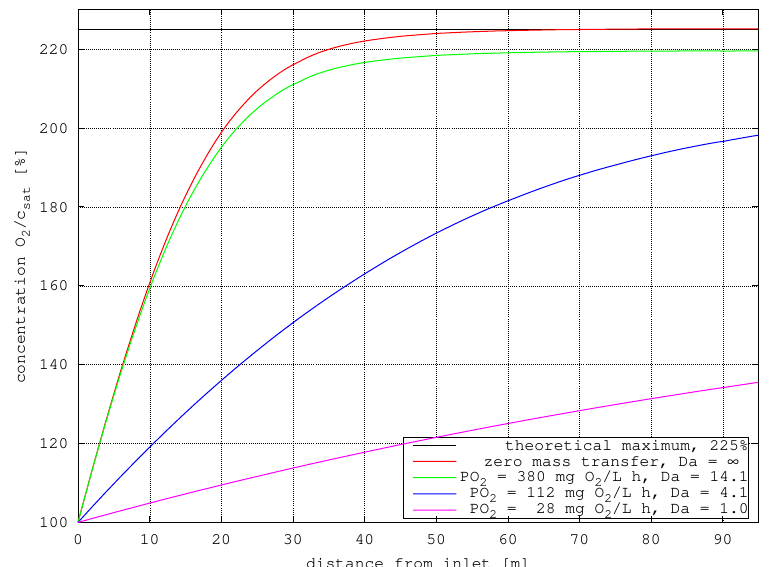
Figure 4. Concentration profiles of dissolved oxygen along the thin layer reactor described by Equation (7) for various values of Damköhler